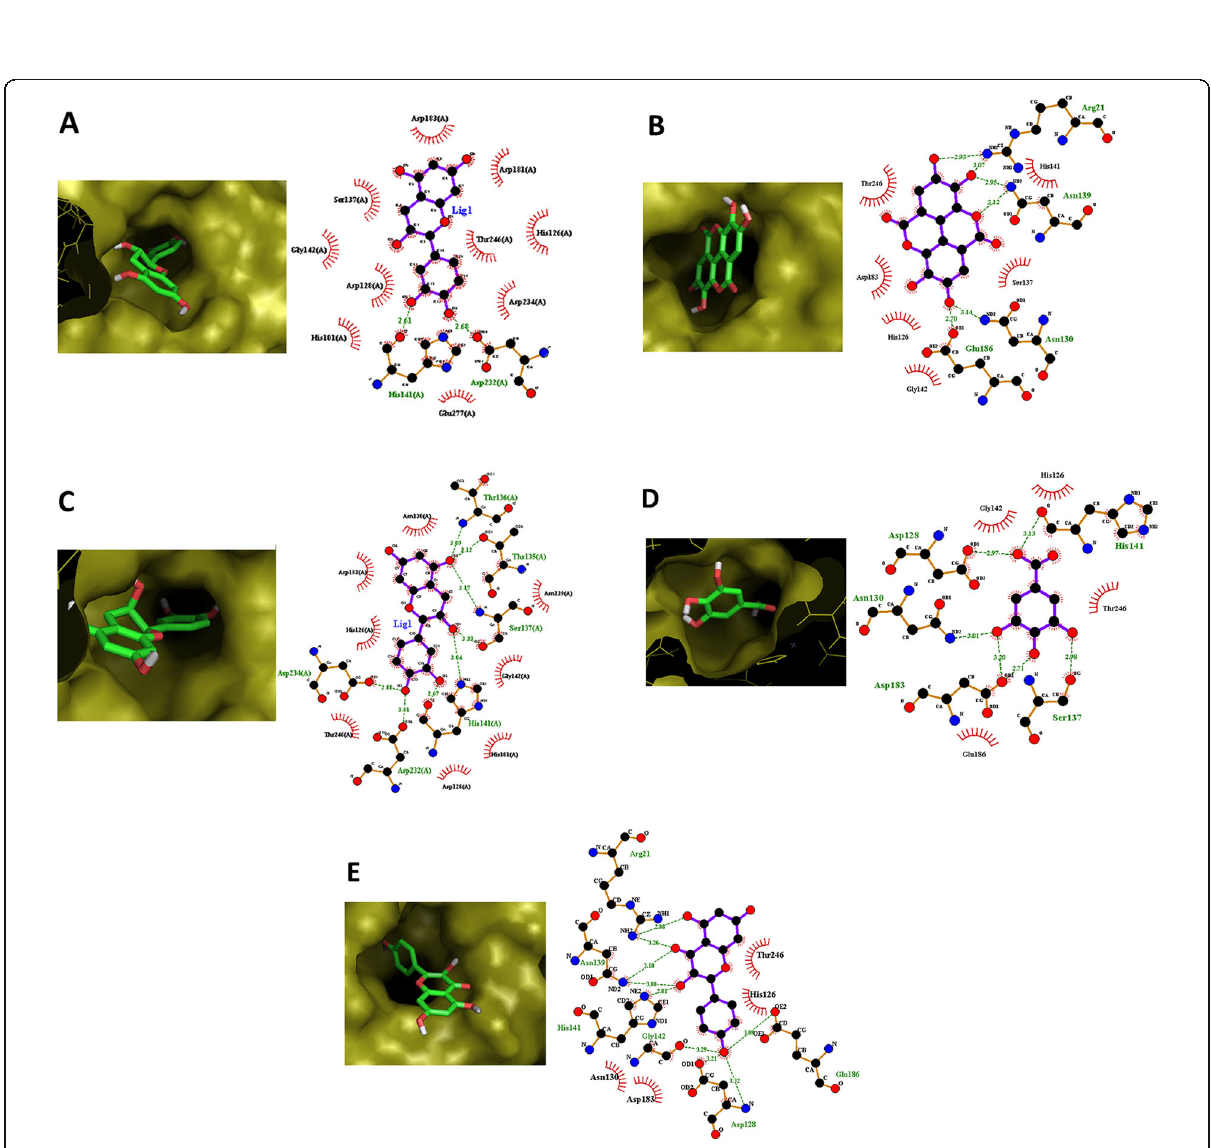
Fig. 8 The binding configuration of M . indica phytoconstituents and interaction analysis. Binding poses of a Catechin, b Ellagic acid, c Epicatechin, d Gallic acid, e Kaempferol on arginase I active site as obtained from molecular docking using Autodock Vina. Result of 2D interaction analysis shows hydrogen bond (green dashed lines) and hydrophobic interaction (red curved lines) using